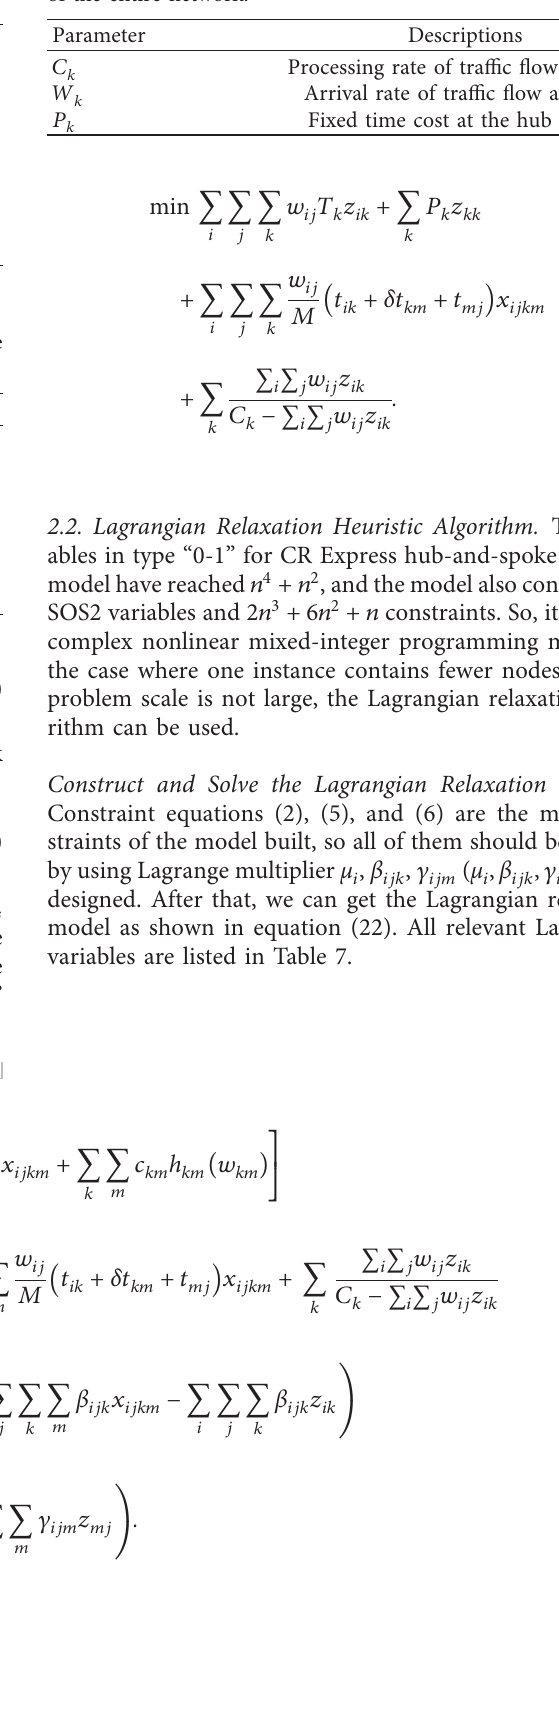
Table 6: The variables used for illustrating the average congestion of the entire network.